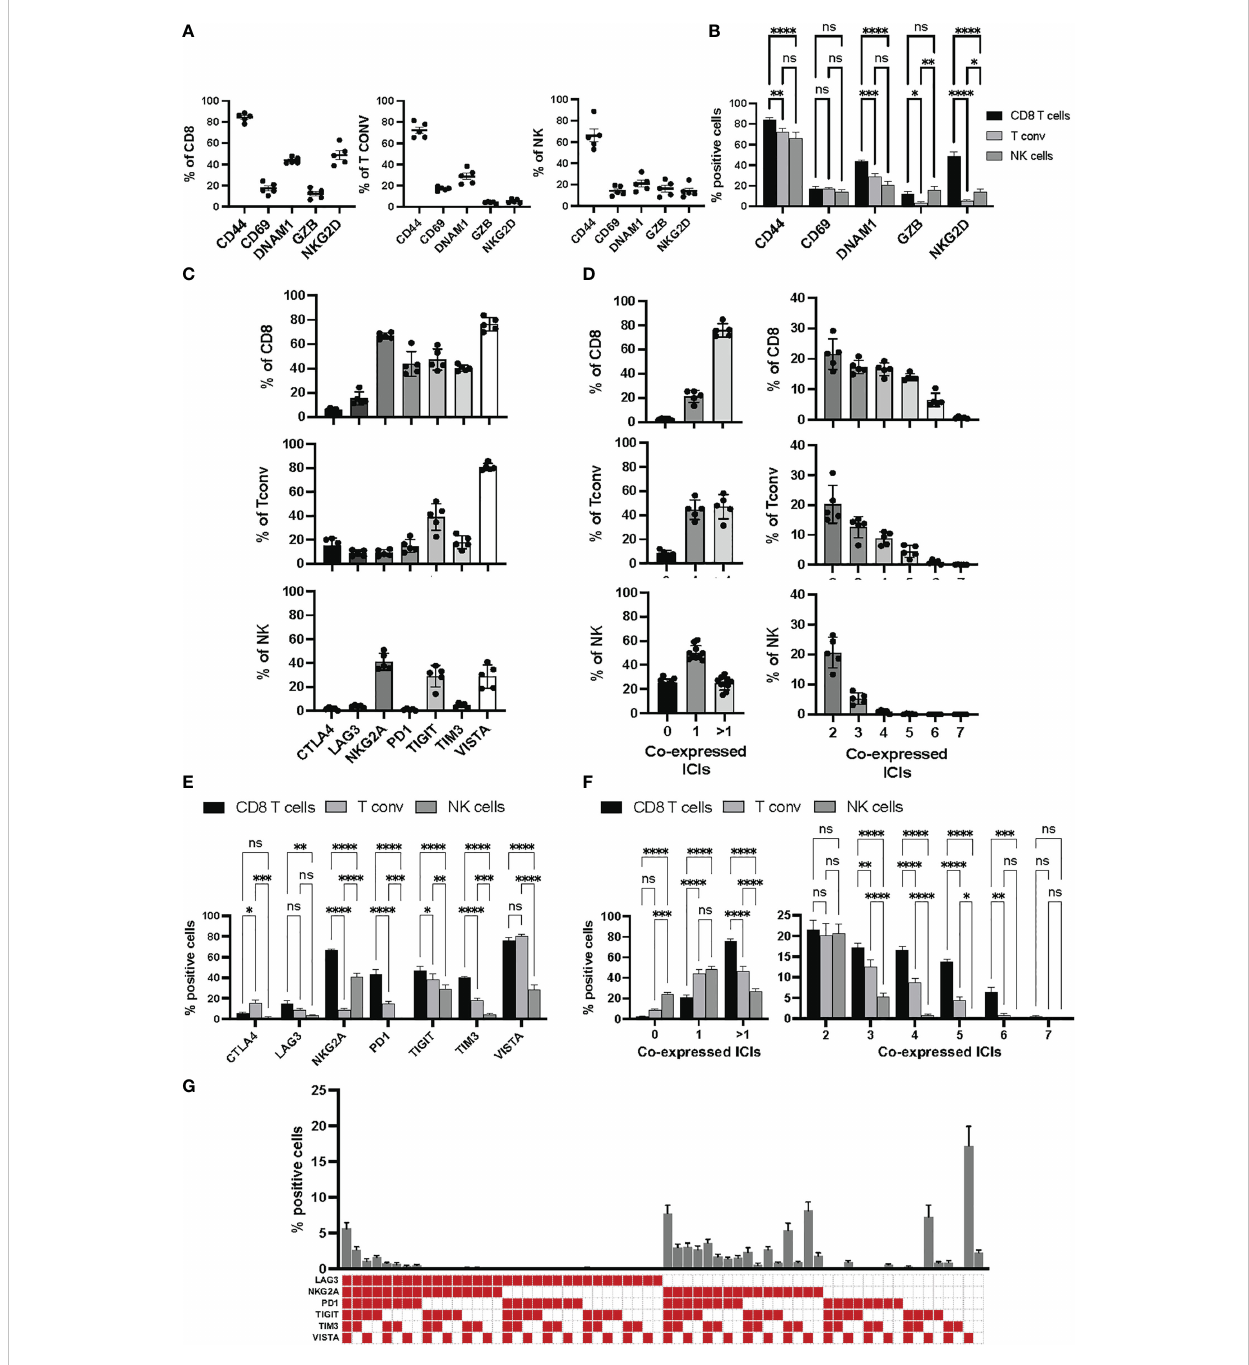
FIGURE 3 Activation and immune checkpoint marker expression in Panel 1. Tumor in fi ltrating immune cells from YUMM UV 1.7 tumors were analyzed as described in Figure 2A. (A) Percentages of cells expressing the indicated activation markers within the CD8 + (left), T conv (middle) or NK (right) cell populations. (B) Percentages in (A) were grouped to directly compare differences in the percentages of each activation markers across CD8 + T cells, T conv, and NK cells. Data are presented as mean values ± SEM. 0.1234 (ns), 0.0332 (*), 0.0021 (**), 0.0002 (***), <0.0001 (****) (Two-Way ANOVA, Fisher ’ s LSD test). (C) Percentages of cells expressing the indicated immune checkpoint molecules within the CD8 + (top), T conv (middle) or NK (bottom cell populations. (D) Boolean gating for the identi fi cation of the percentage of cells expressing 0, 1 or >1 immune checkpoint inhibitors (ICIs, left column) and 2 to 7 immune checkpoint inhibitors (ICIs, right column) within the CD8 + (top), T conv (middle) or NK (bottom) cell populations. (E) Percentages in (C) were grouped to directly compare differences in the percentages of each immune checkpoint inhibitor across CD8 + T cells, T conv, and NK cells. Data are presented as mean values ± SEM. 0.1234 (ns), 0.0332 (*), 0.0021 (**), 0.0002 (***), <0.0001 (****) (Two-Way ANOVA, Fisher ’ s LSD test). (F) Percentages in (D) were grouped to directly compare differences in the percentages of cells co-expressing the indicated numbers of immune checkpoint inhibitors (ICIs) across CD8 + T cells, T conv , and NK cells. Data are presented as mean values ± SEM. 0.1234 (ns), 0.0332 (*), 0.0021 (**), 0.0002 (***), <0.0001 (****) (Two-Way ANOVA, Fisher ’ s LSD test). (G) Boolean gating (FLowJo) for 6 different immune checkpoint inhibitors on tumor in fi ltrating CD8 + T cells. The graph represents the percentage of tumor in fi ltrating CD8 + T cell positive for any of the immune checkpoint combinations indicated by the red square below the x axes. Data are presented as mean values ± SEMs,